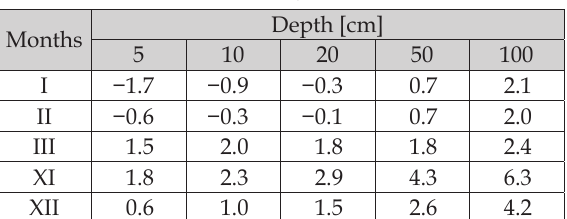
Table 5. Values of the 1st empirical percentile of daily mean soil temperature (°C) at various depths in Poznań during the period November–March (2011–